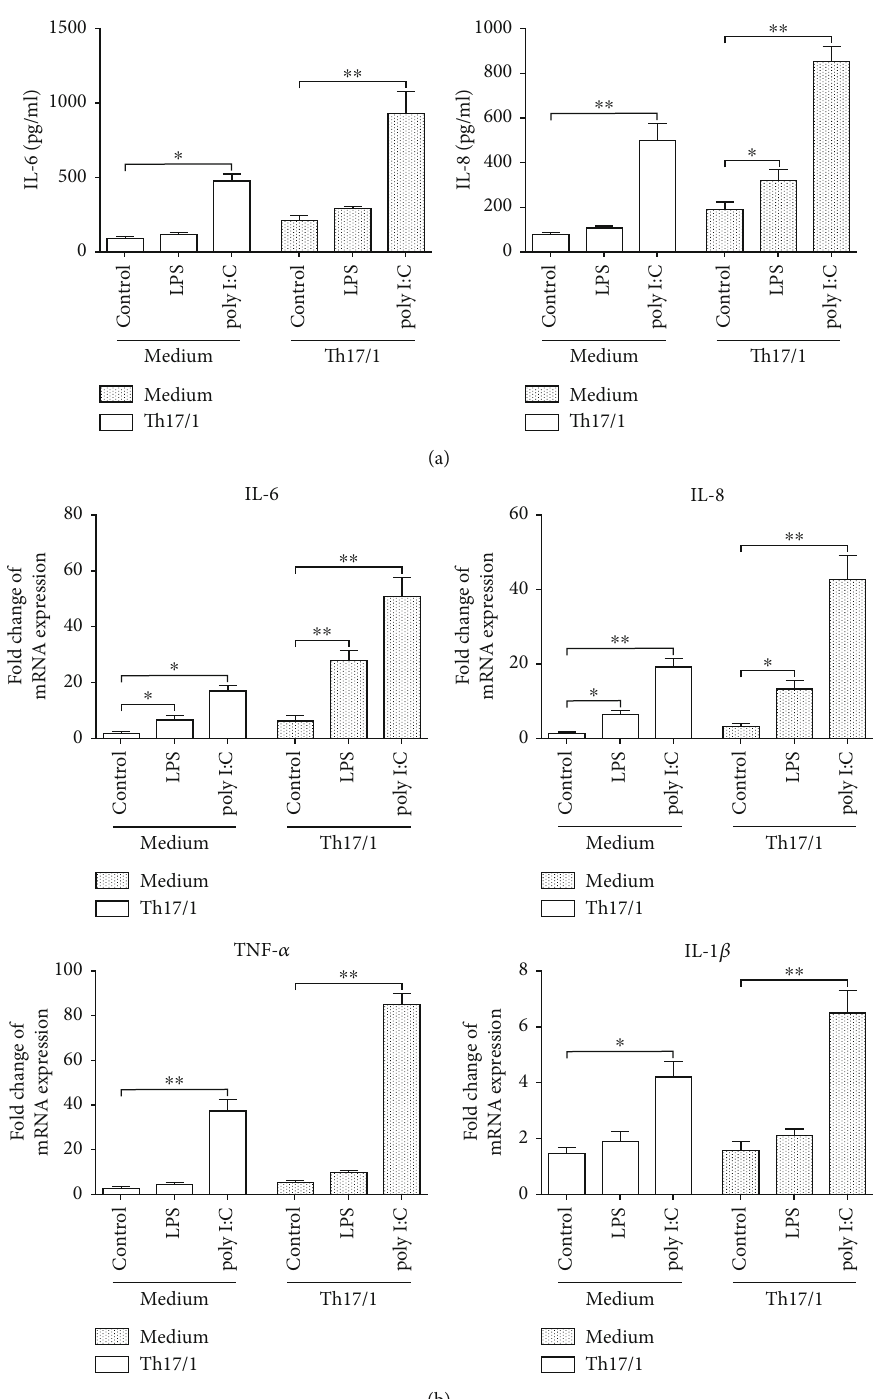
Figure 6: E ff ect of a Th17/1 environment on the proin fl ammatory response of NP69 cell to stimuli. NP69 cells were cultured in the presence or absence of human IFN- γ and IL-17A for 48 hours, then stimulated with either poly I:C or LPS for 4h in serum-free media. (a) Summary data showed IL-6 and IL-8 expression levels by NP69 cells ( n = 5 ). (b) Summary data showed mRNA expression of IL-6, IL-8, TNF- α , and IL- 1 β in NP69 cells ( n = 5 ). Data were shown as the mean ± SEM . Statistical signi fi cance was determined with the Mann – Whitney test. ∗ p < 0 : 05 ; ∗∗ p < 0 : 01 ; ∗∗∗ p < 0 : 001